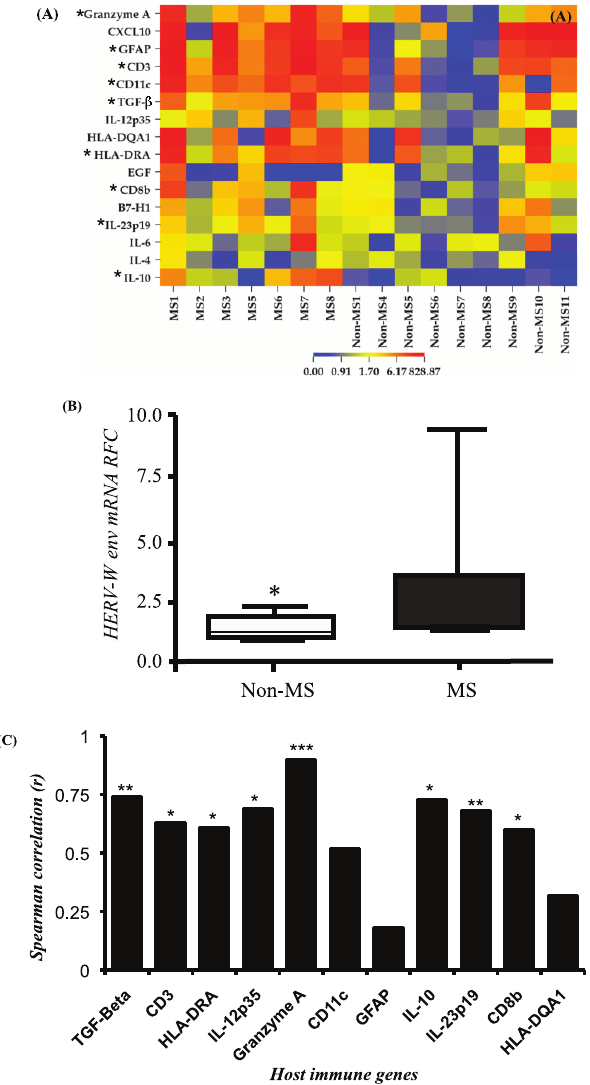
Figure 2. HERV-W env and immune gene expression in brain white matter. ( A ) A heatmap showing relative expression of host immune genes relevant to neuroinflammation in MS and non-MS white matter samples, generated based on real time RT-PCR studies (* indicates statistically up- or down regulated genes). ( B ) Median HERV- W env transcript levels in non-MS and MS autopsied white matter specimens showing increased levels in MS brain-derived samples. ( C ) Regression analyses of host immune gene with HERV-W env transcript abundance. Transcripts expressed as relative fold change to the house keeping gene, GAPDH. (Spearman r; Mann-Whitney, U test, * p , 0.05, ** p , 0.005, *** p , 0.0005). Given the association of Syncytin-1 with neuroinflammation (Figure 1), select immune genes, based on transcript-derived tag frequency were interrogated for their expression levels in all five healthy brain specimens ( Figure 5C ). The resulting heat map showed there was differential expression of immune genes distinguishing fetal from adult brains and this profile was interpreted in relation to HERV-W env transcript abundance. Of particular interest was the relative reduction in STAT4 and TLR4 with a concurrent increase in nestin in the fetal samples ( Figure 5C ). Vimentin was consistently expressed across all